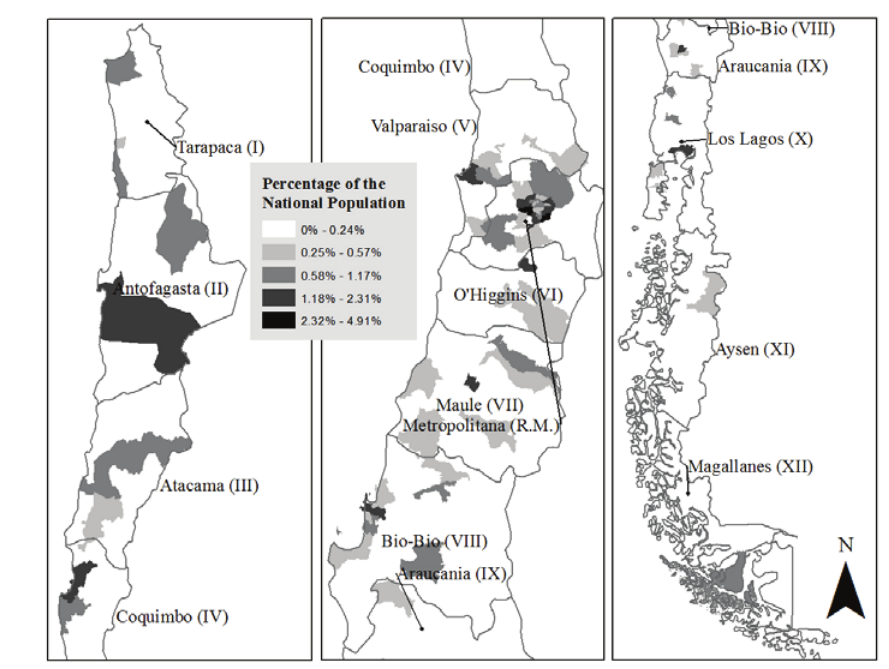
Figure 1. Map of Chile and its regional and communal administrative